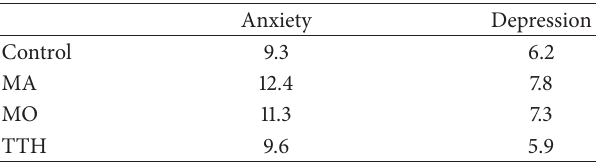
Table 1: GAD-7 and PHQ-9 average scores in different diagnostic